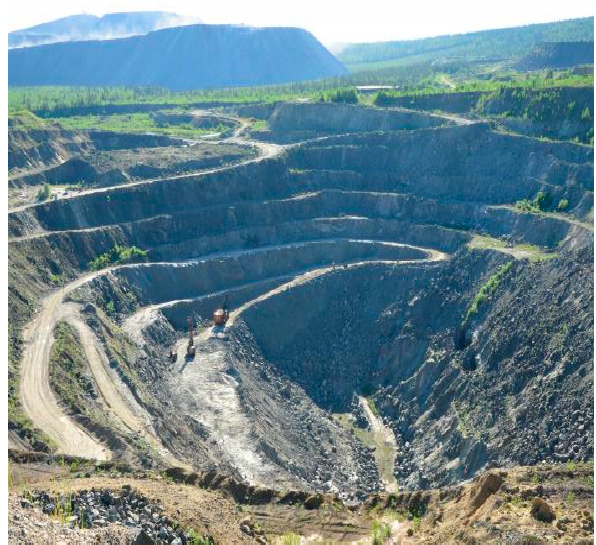
Figure 1. Enterprise quarry.